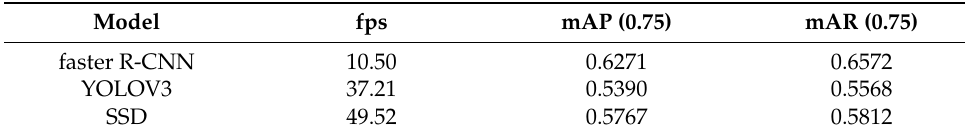
Table 1. Driving operation area detection result.